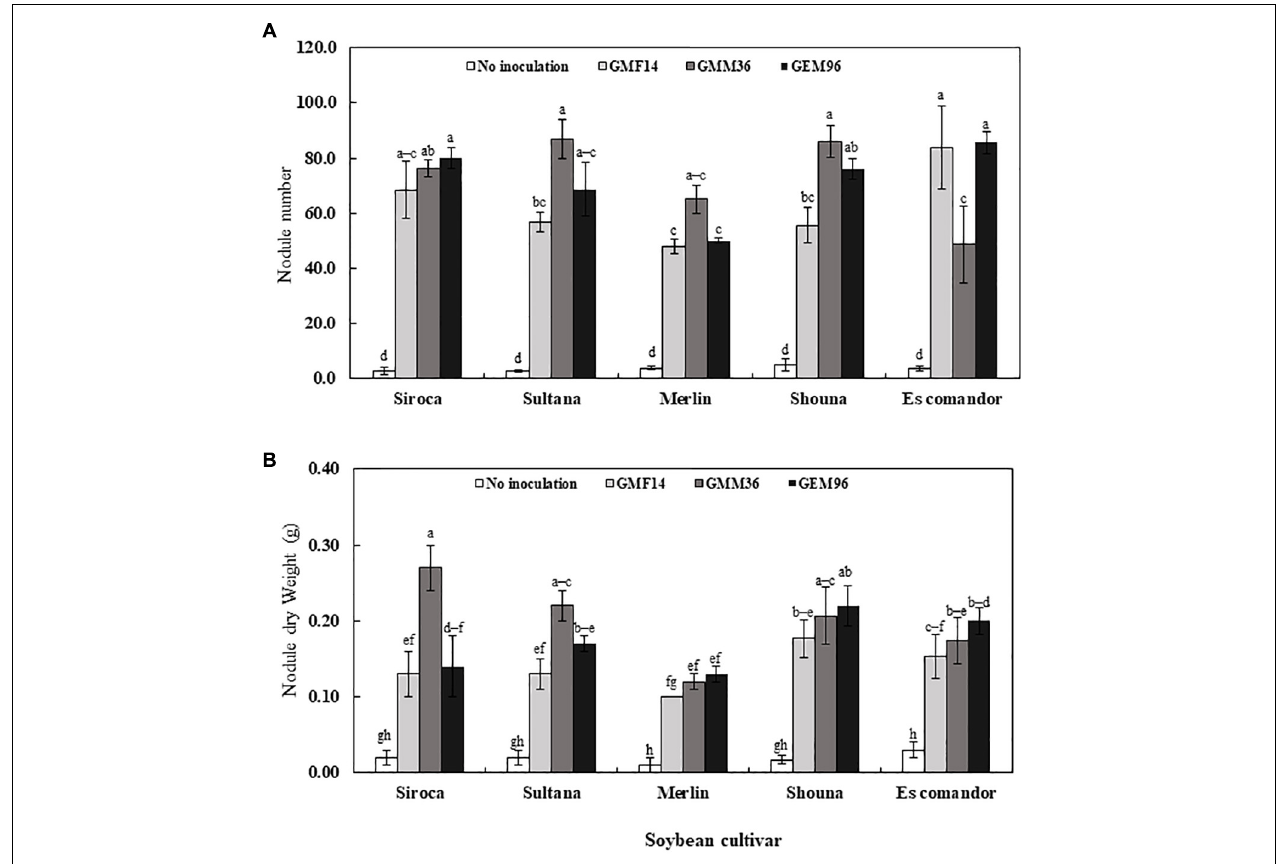
FIGURE 4 | Soybean nodule number (A) and nodule dry weight (B) following inoculation of different Bradyrhizobium strains to five soybean culuVars in the first greenhouse experiment. The error bars are standard deviation of three replications ( n = 3). Values followed by the same letters on each bar are not significantly different at p ≤